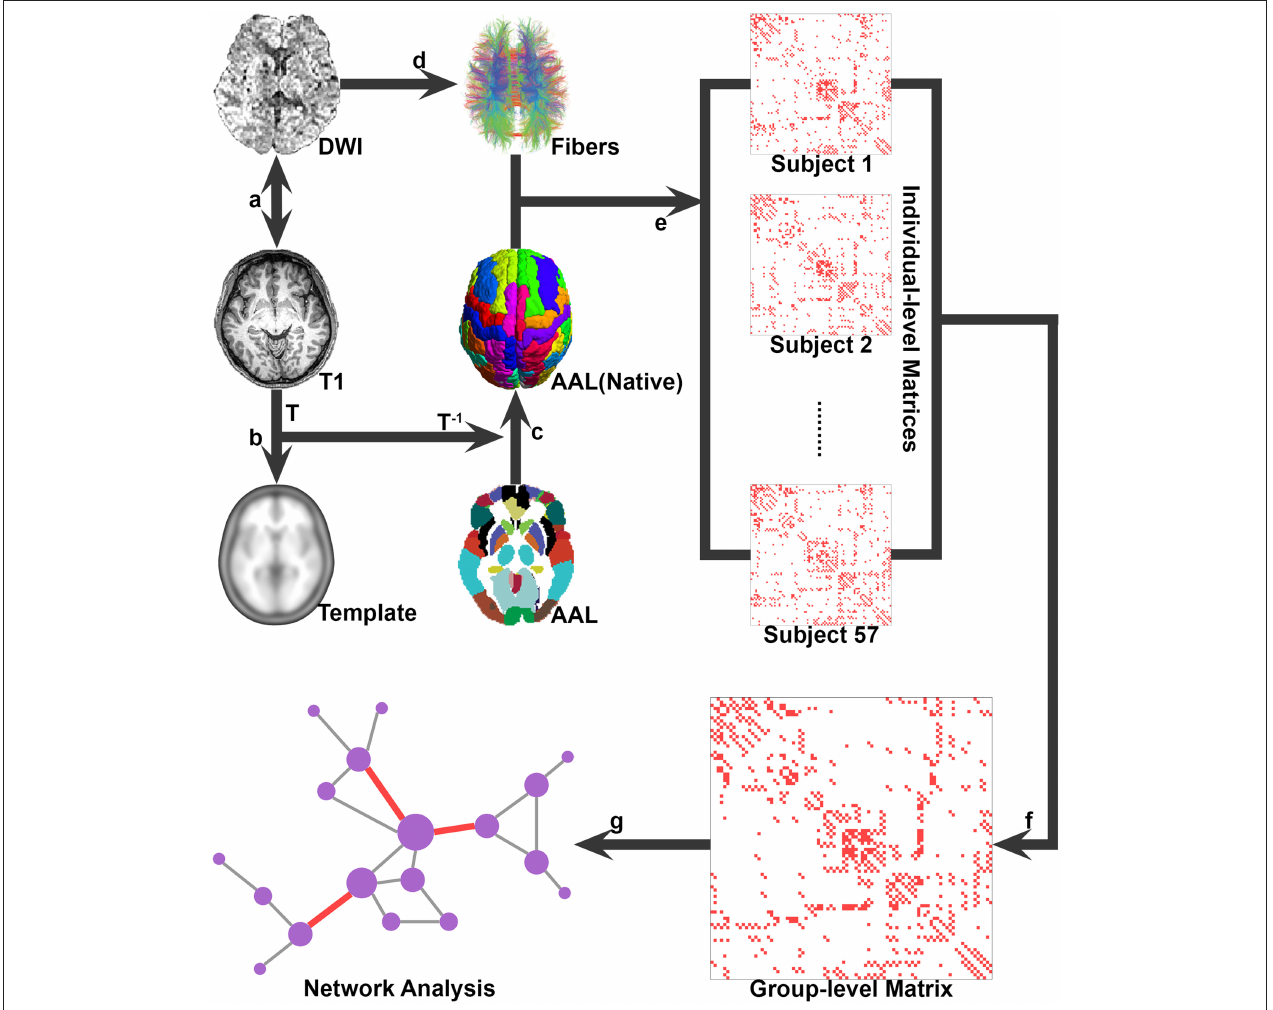
FIGURE 1 | A flowchart for the construction of the whole-brain WM network. (A) The T1-weighted image was firstly rigidly coregistered to the averaged b0 image in native diffusion space; (B) The transformed T1 image was then nonlinearly transformed to the ICBM152 T1 template in the MNI space, and the transformation matrix T was estimated; (C) the inversed transformation T-1 was used to warp the AAL atlas from the MNI space to the native diffusion space, obtaining the parcellation for each individual; (D) the whole-brain WM tracts were reconstructed by using deterministic tractography; (E) the WM fibers connecting each pair of regions were determined for each subject, thus the individual WM networks were constructed; (F) the group-level connectivity matrix was computed by selecting all connections that were present in at least 50% of the group of individuals; and (G) both the individual and group-level networks were further analyzed by using graph theoretical